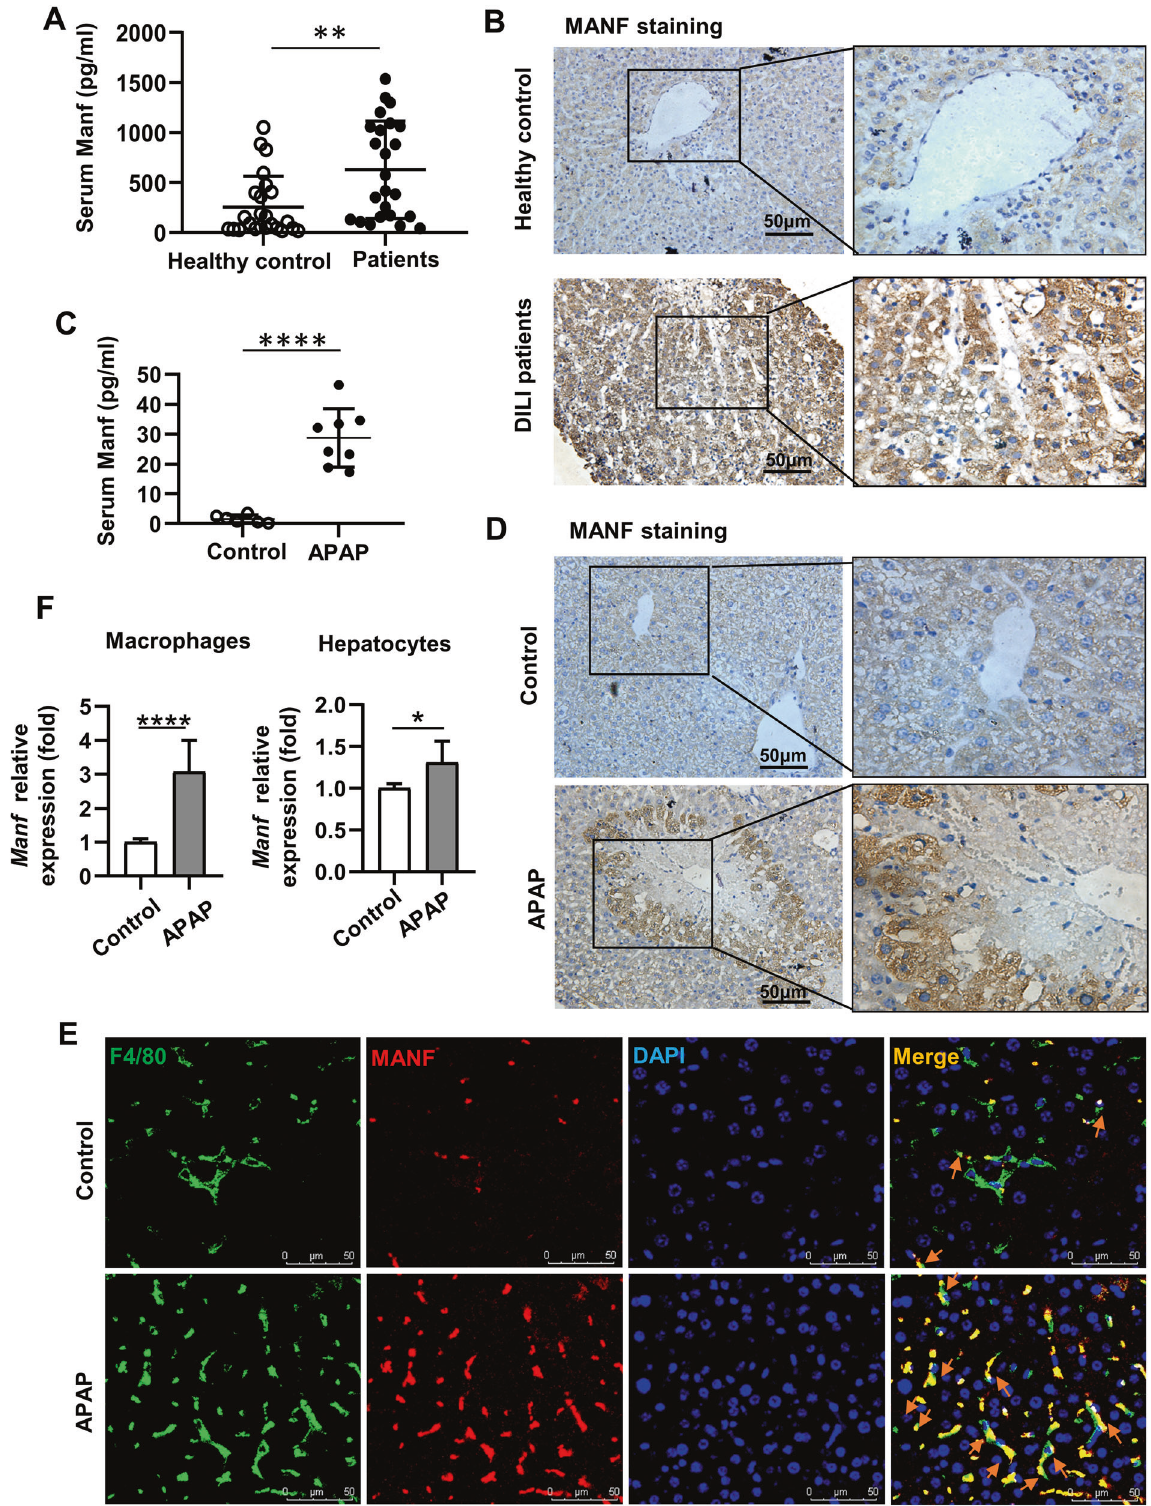
Fig. 1 Increased MANF expression in drug-induced liver injury (DILI) patients and an AILI mouse model. A MANF was measured in serum samples of DILI patients ( n = 24) and healthy controls ( n = 24). B Representative immunohistochemical (IHC) images of hepatic MANF expression in DILI patients and healthy controls. C Serum levels of MANF in WT mice 24 h post APAP treatment were determined by ELISA. D Representative IHC images of hepatic MANF expression in mice 24 h after APAP treatment and in control mice. E Immuno fl uorescence staining for F4/80 (green), MANF (red) and DAPI for nuclei (blue) in WT mice liver tissue. Orange arrows point to F4/80 + macrophages with high expression of MANF. F Relative mRNA expression of MANF in macrophages and hepatocytes at 0 h (control) and 12 h after APAP treatment was determined by qPCR. Data are presented as mean ± SD and representative of at least 3 independent experiments. n = 6 – 8 per group. * P < 0 .05, ** P < 0.01. Cell Death and Disease (2022)